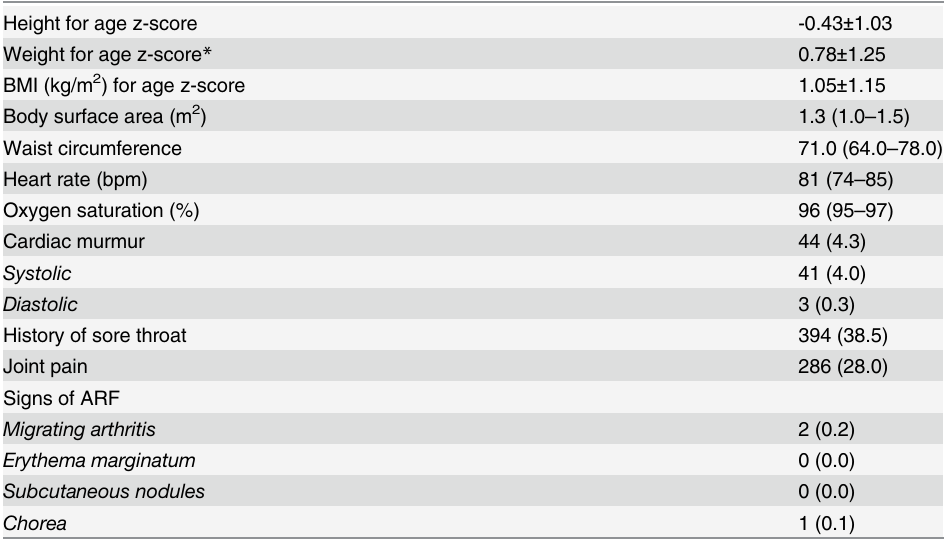
Table 2. Physical examination.